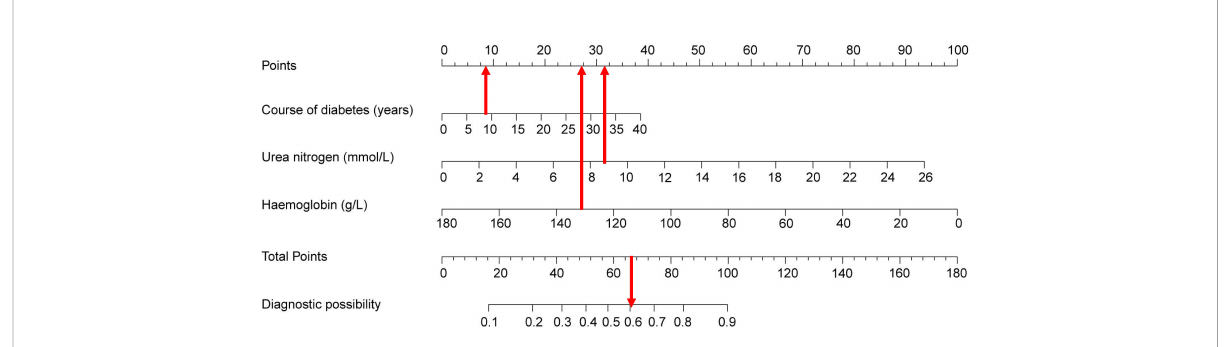
FIGURE 6 Visualization of nomogram to predict the risk of concomitant peripheral artery disease in patients with type 2 diabetes mellitus